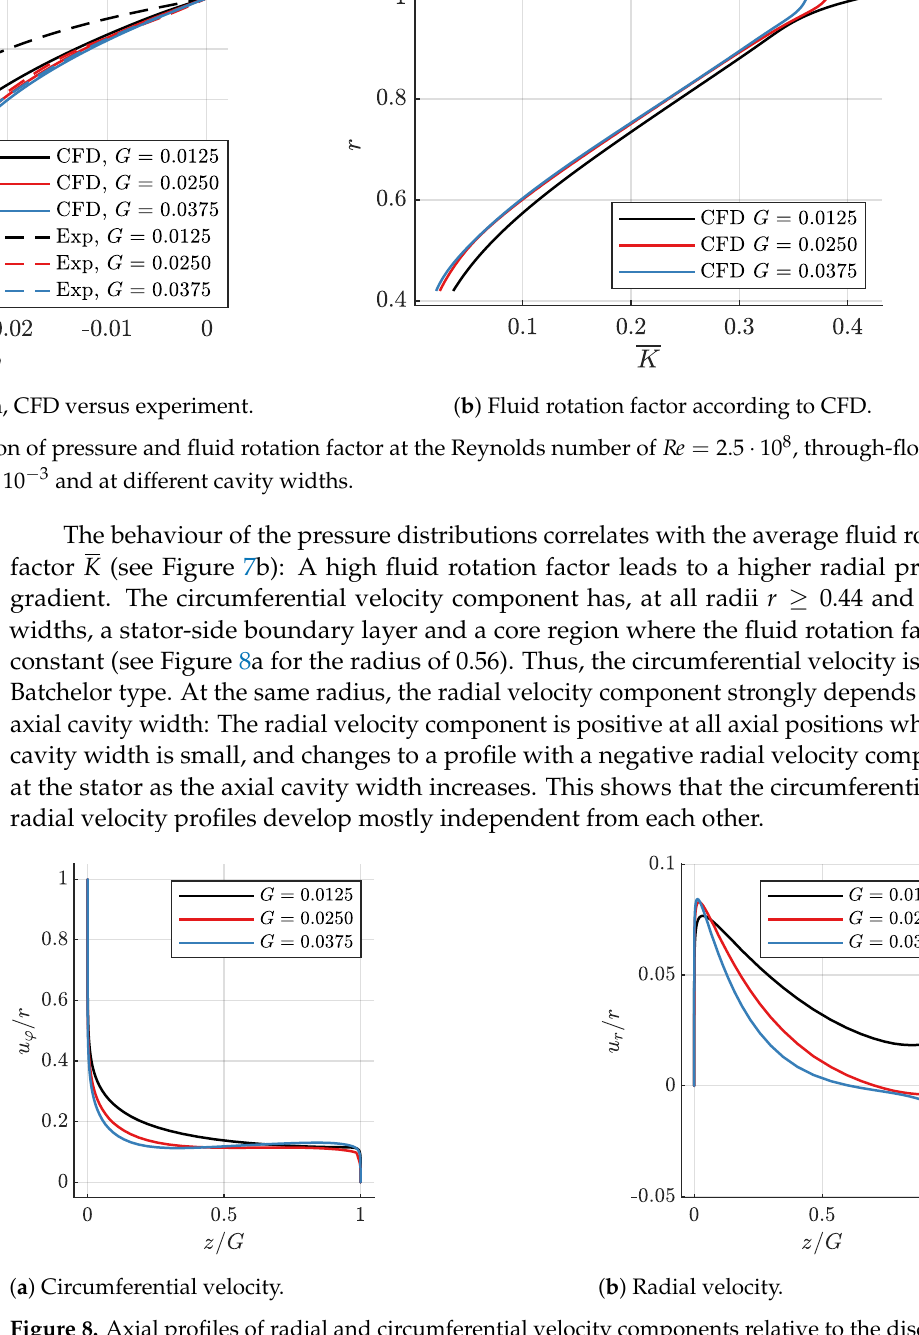
Figure 8. Axial profiles of radial and circumferential velocity components relative to the disc speed at the radius of 0.56 and at the Reynolds number of Re = 2.5 · 10 8 , through-flow mass flow rate of ˙ m = 1.1 · 10 − 3 and at different cavity widths. Simulation